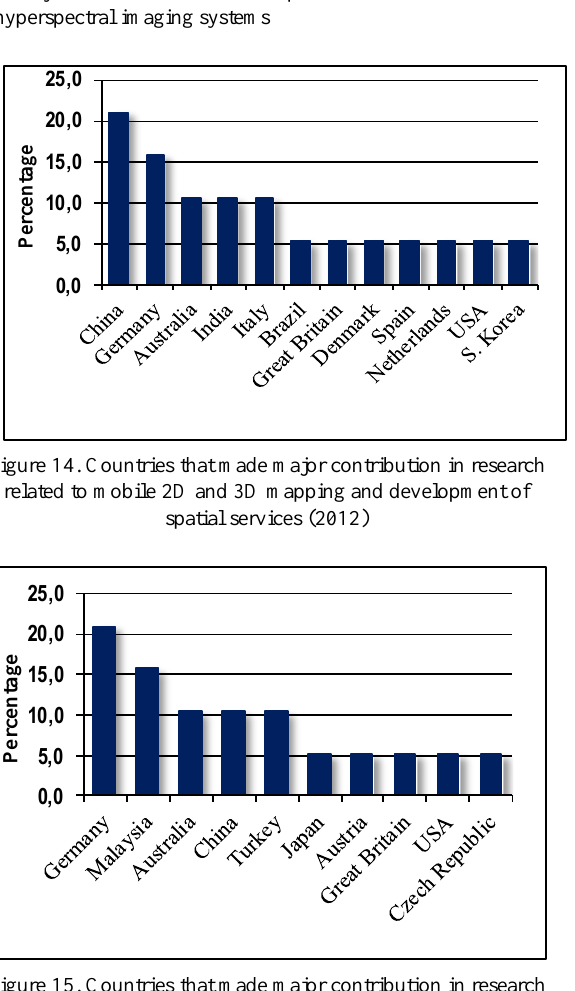
Figure 13. Countries that made major contribution in research related to point cloud processing (2012)